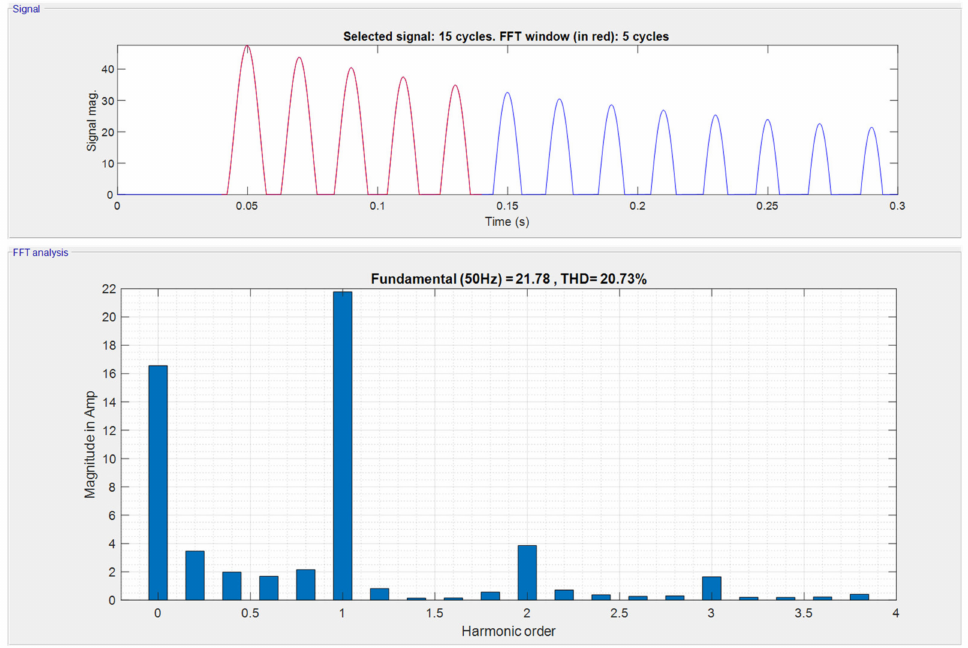
Figure 11. Analysis of inrush currents using FFT for new materials (metglass).